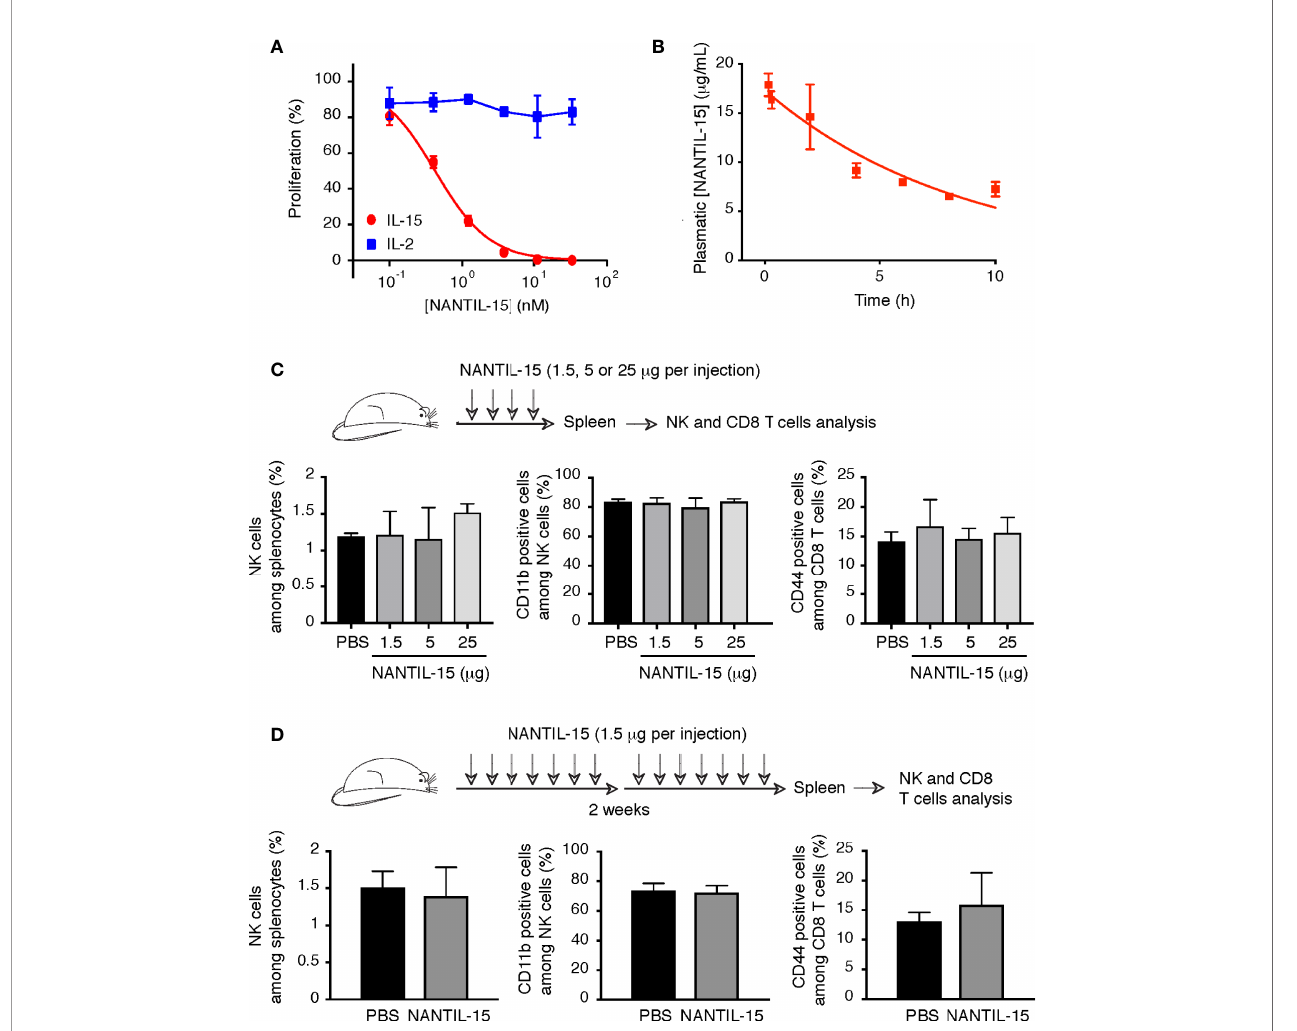
FIGURE 4 | NANTIL-15 administration does not affect NK and memory CD8 T-cell homeostasis. (A) Inhibition of IL-15 (10 pM) or IL-2 (100 pM) induced CTLL-2 cell proliferation by increasing concentrations of NANTIL-15. (B) The half-life of NANTIL-15 was evaluated in C57BL/6 mice after a single intravenous injection of 10 µg of the molecule. At each time point (n = 3), the blood was collected. NANTIL-15 concentration in the serum was determined by ELISA. (C) Analysis of total splenic NK cells, mature (CD11b + ) NK cells, and CD44 + CD8 T cells following i.p. injection of 1.5, 5, or 25 m g of NANTIL-15 (every day for 4 days). (D) Analysis of total splenic NK cells, mature (CD11b + ) NK cells, and CD44 + CD8 T cells following repeated i.p. injections of 1.5 m g of NANTIL-15 (every day for 2 weeks). All data are representative of at least two separate experiments (n = 3, each